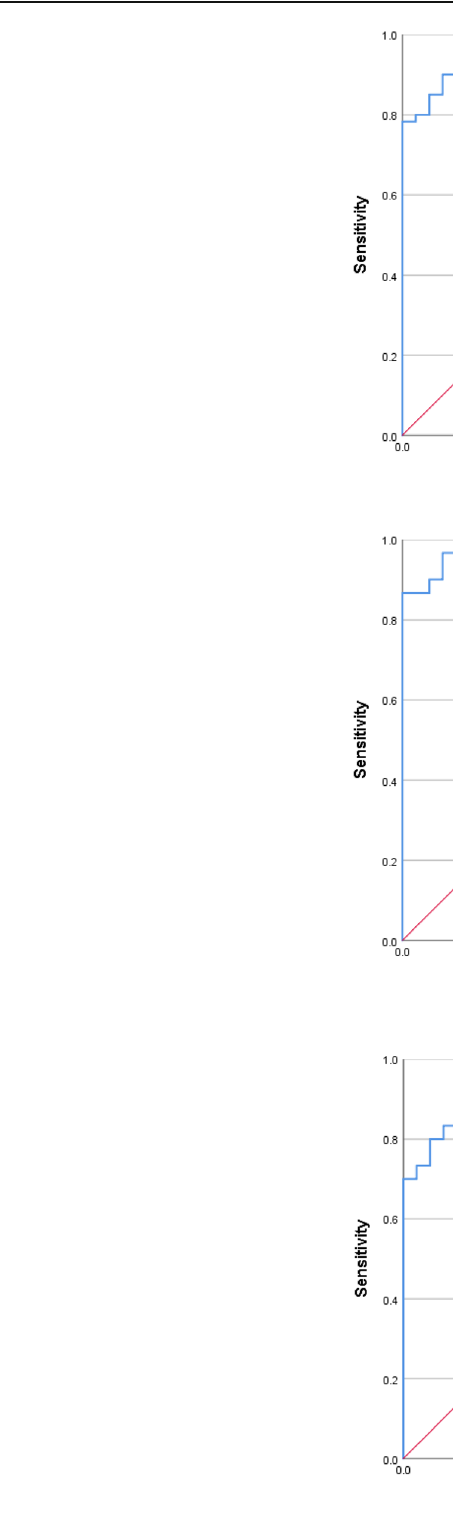
Fig. 1 Receiver operating characteristic (ROC) analysis for sHLA-G antigens showing area under curve (AUC) in IBD (AUC = 0.944; 95% CI = 0.898 – 0.990; p < 0.001; sensitivity = 90.0%; specificity = 90.0%; cut-off value = 145.2 ng/ml), UC (AUC = 0.961; 95% CI = 0.902 – 1.000; p < 0.001; sensitivity = 96.7%; specificity = 90.0%; cut-off value = 145.2 ng/ml) and CD (AUC = 0.928; 95% CI = 0.860 – 0.993; p < 0.001; sensitivity = 83.3%; specificity = 83.3%; cut-off value = 145.2